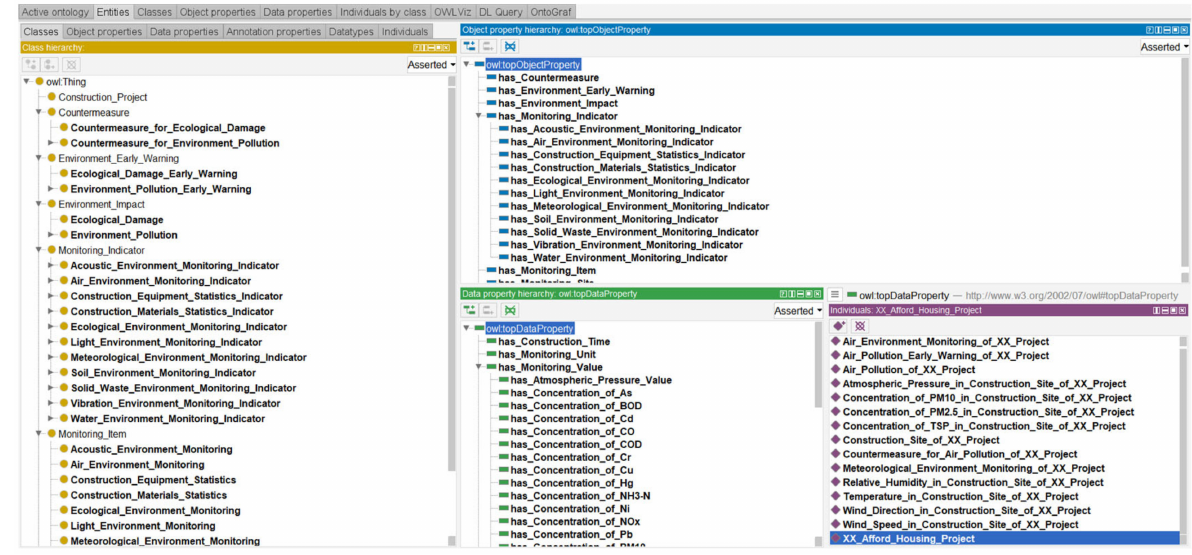
Figure 3. Final ontology